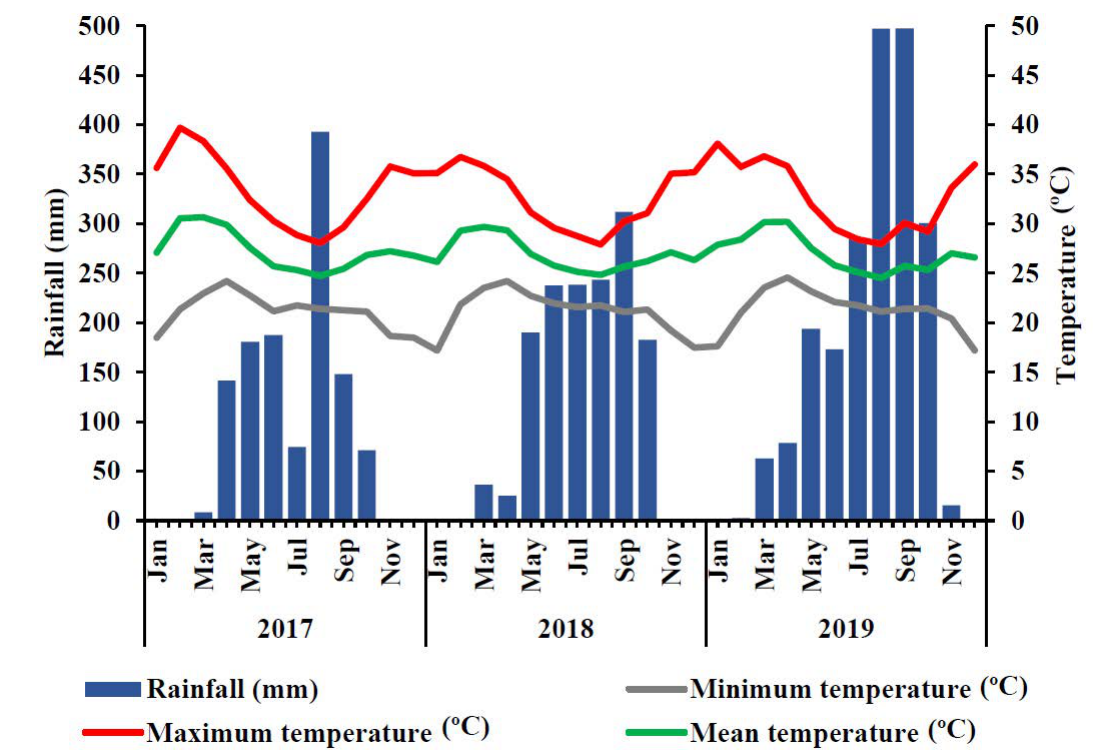
Figure 1. Rainfall and temperature during the cropping seasons from 2017 to 2019 at International Institute of Tropical Agriculture Station, Abuja,